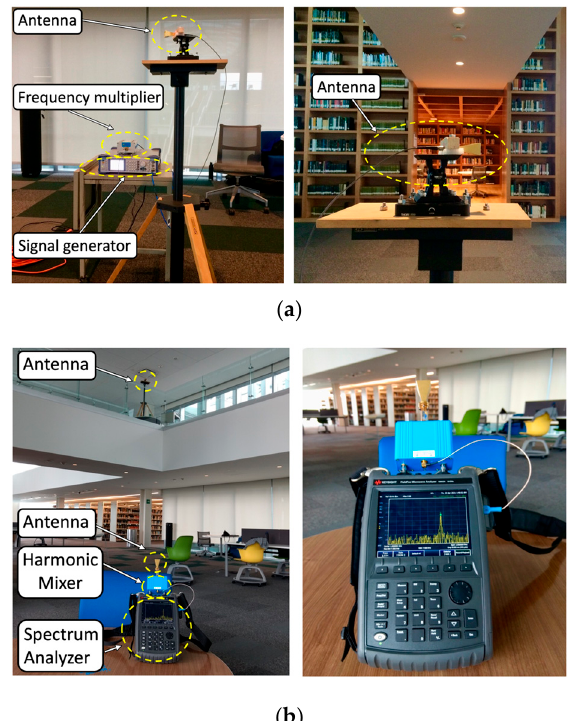
Figure 7. Measurement setup at 60 GHz frequency on the first and second floors of the library: ( a ) transmitter and ( b ) receiver.